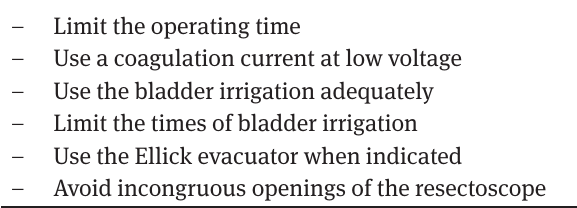
Figure 1: CT scan showing hypodense area at the head of the left caudate nucleus